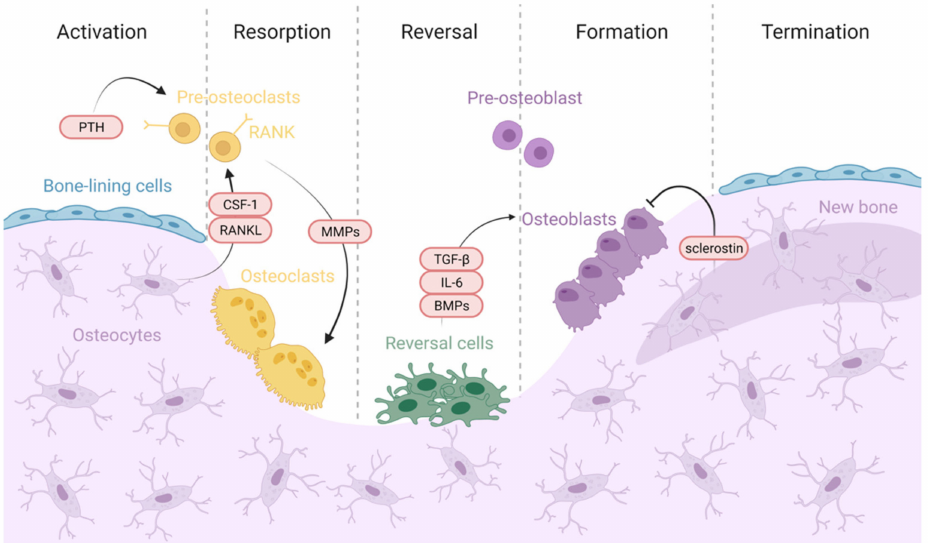
Figure 2. Bone remodeling process. Activation: Bone in quiescent state detects an initiating signal triggered by mechanical forces, microdamage, or systemic hormones such as PTH [23,24]. Osteocyte apoptosis is then induced [3,15], releasing osteoclastogenic factors such as colony-stimulating factor 1 (CSF-1) and receptor activator of NF- κ B ligand (RANKL) that favor osteoclast precursor recruitment and activation [1]. Resorption: Osteoblasts secrete cytokines and matrix metalloproteinases (MMPs) in order to expose RGD adhesion sites to facilitate osteoclast attachment [3]. Osteoclasts dissolve mineralized matrix and organic bone matrix through hydrogen ions and MMP secretion, respec- tively [15]. Reversal: “reversal” cells remove unmineralized collagen matrix and deposit a “cement line” of non-collagenous mineralized matrix to enhance osteoblastic adhesion [23]. The reversal